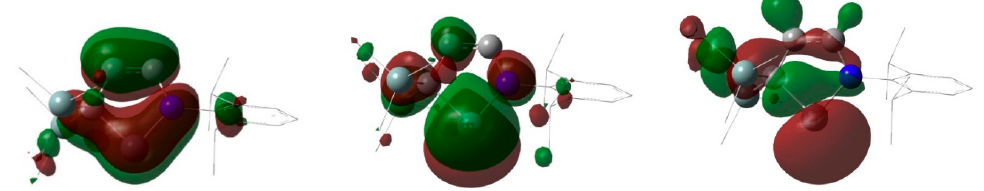
Figure 4. Plots of the HOMO ( left ), LUMO ( middle ) and HOMO–1 ( right ) of 3 calculated at the B3LYP/6-31G(d,p) level of theory (hydrogen atoms are omitted for clarify).